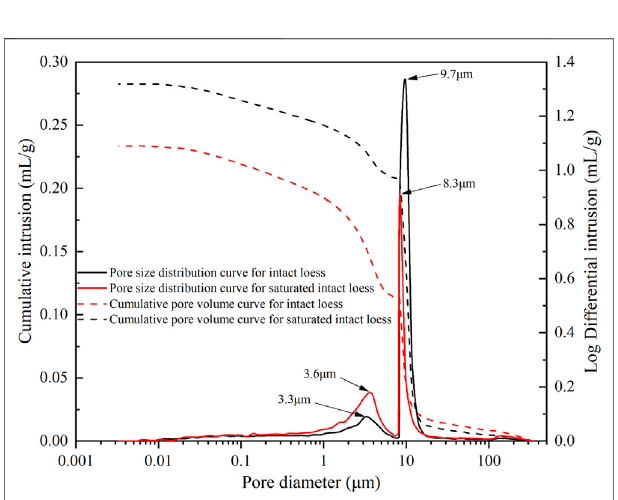
FIGURE 11 | Pore size distribution curves and cumulative pore volume curves of intact loess and saturated loess.